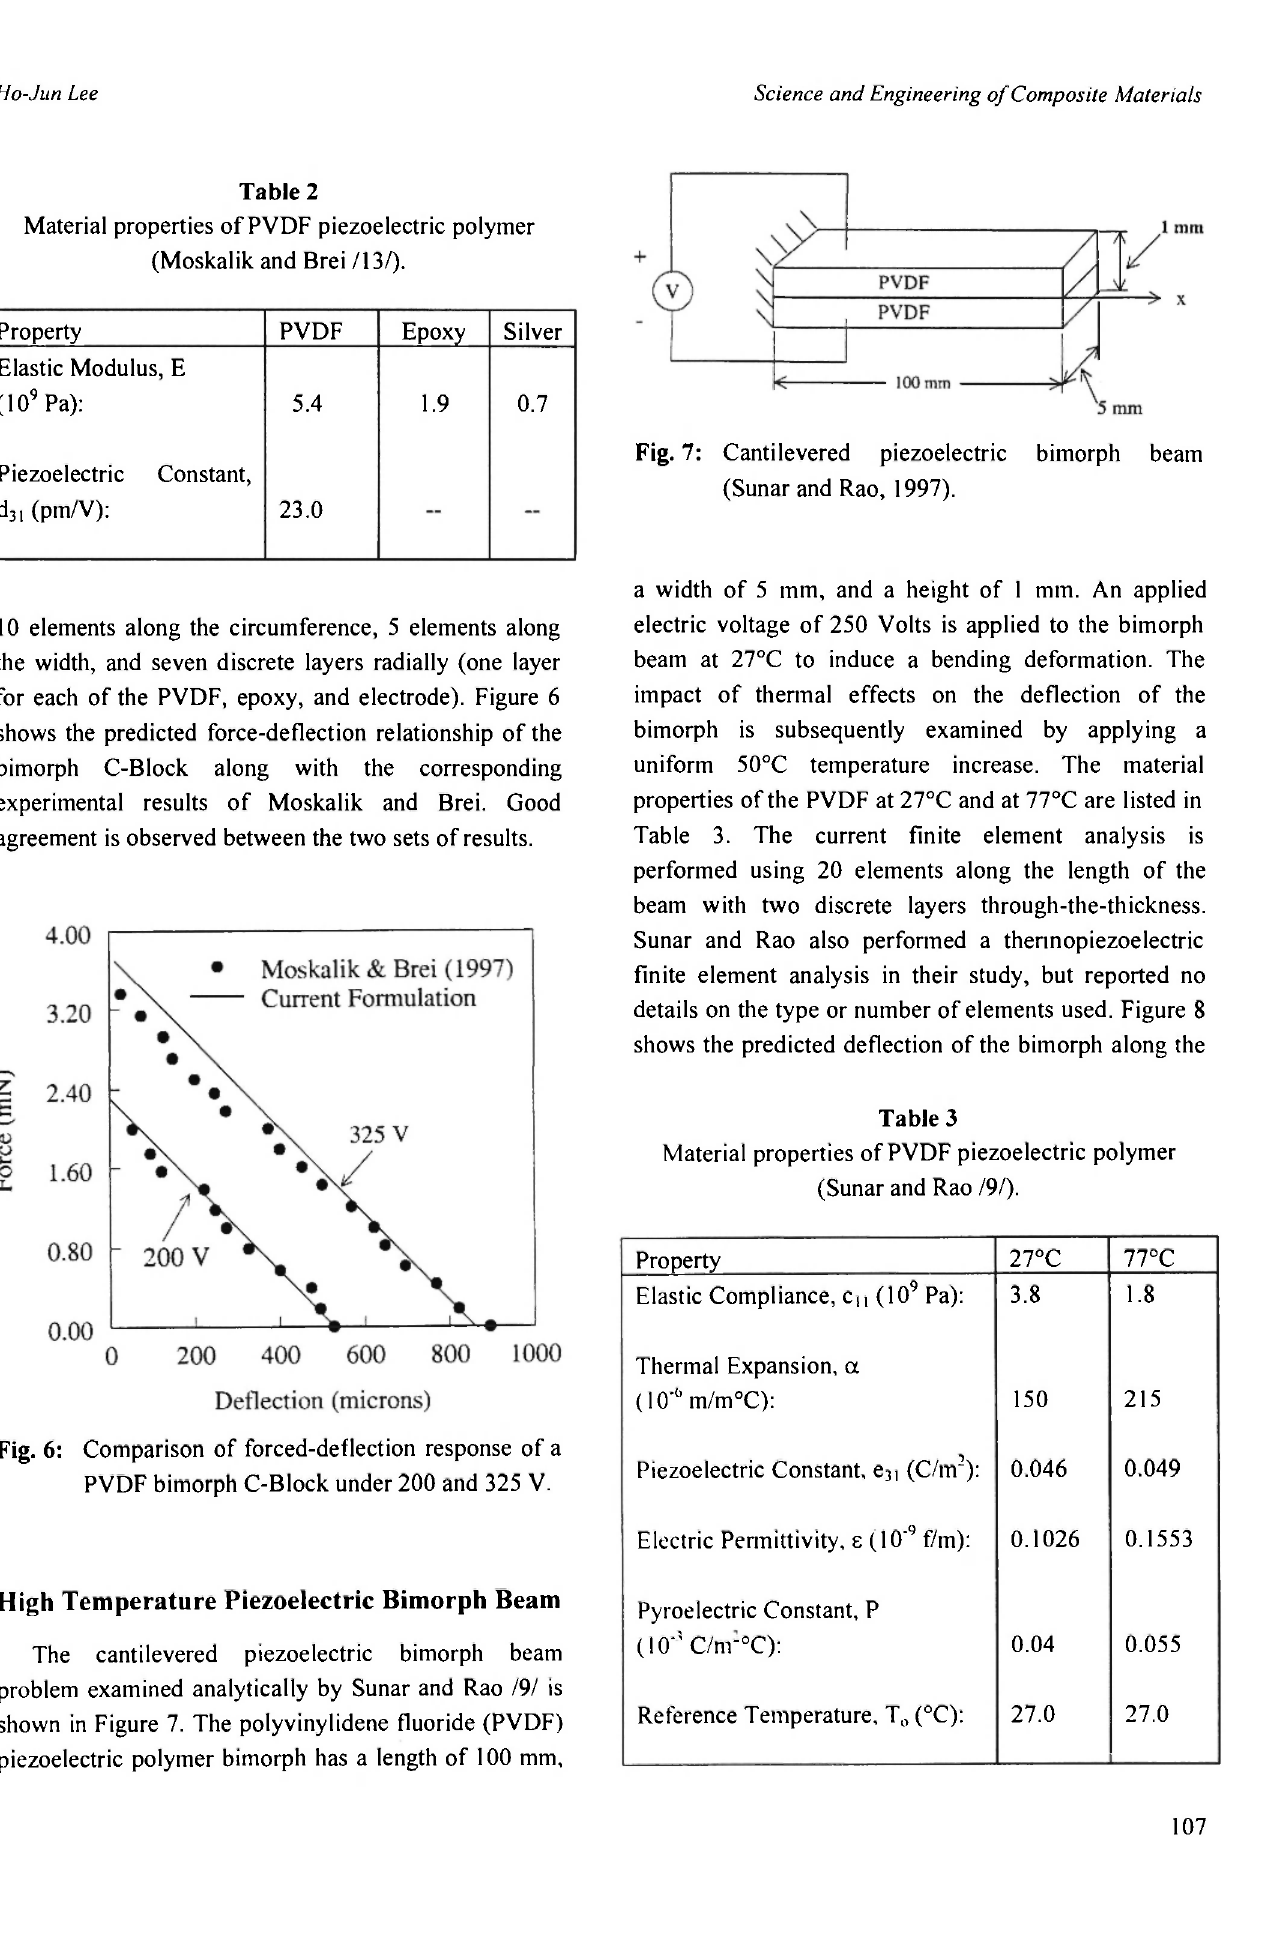
Material properties of PVDF piezoelectric polymer